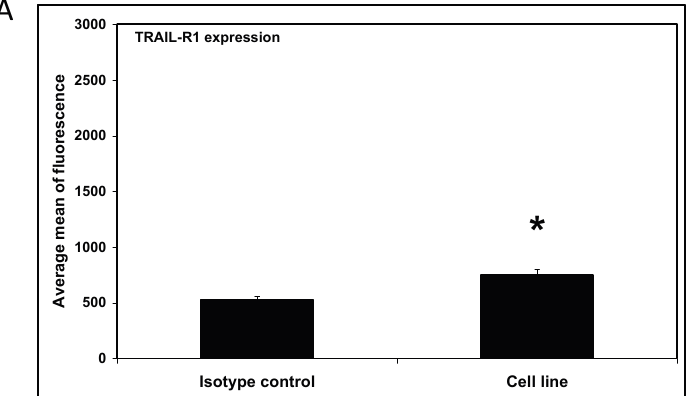
Figure 2. The surface expression of tumor necrosis factor-related apoptosis-inducing ligand (TRAIL) receptors TRAIL-R1 ( A ) and TRAIL-R2 ( B ) on macrophages RAW264.7, analyzed using flow cytometry. The values represent mean ± SD of three independent experiments. * p < 0.05 compared to isotype